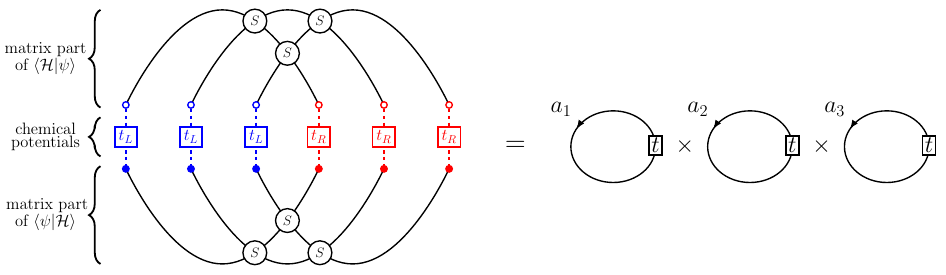
2) L 2) R (cid:13)avour psu (2 j (cid:2) j 2) Beisert’s S -matrix under j